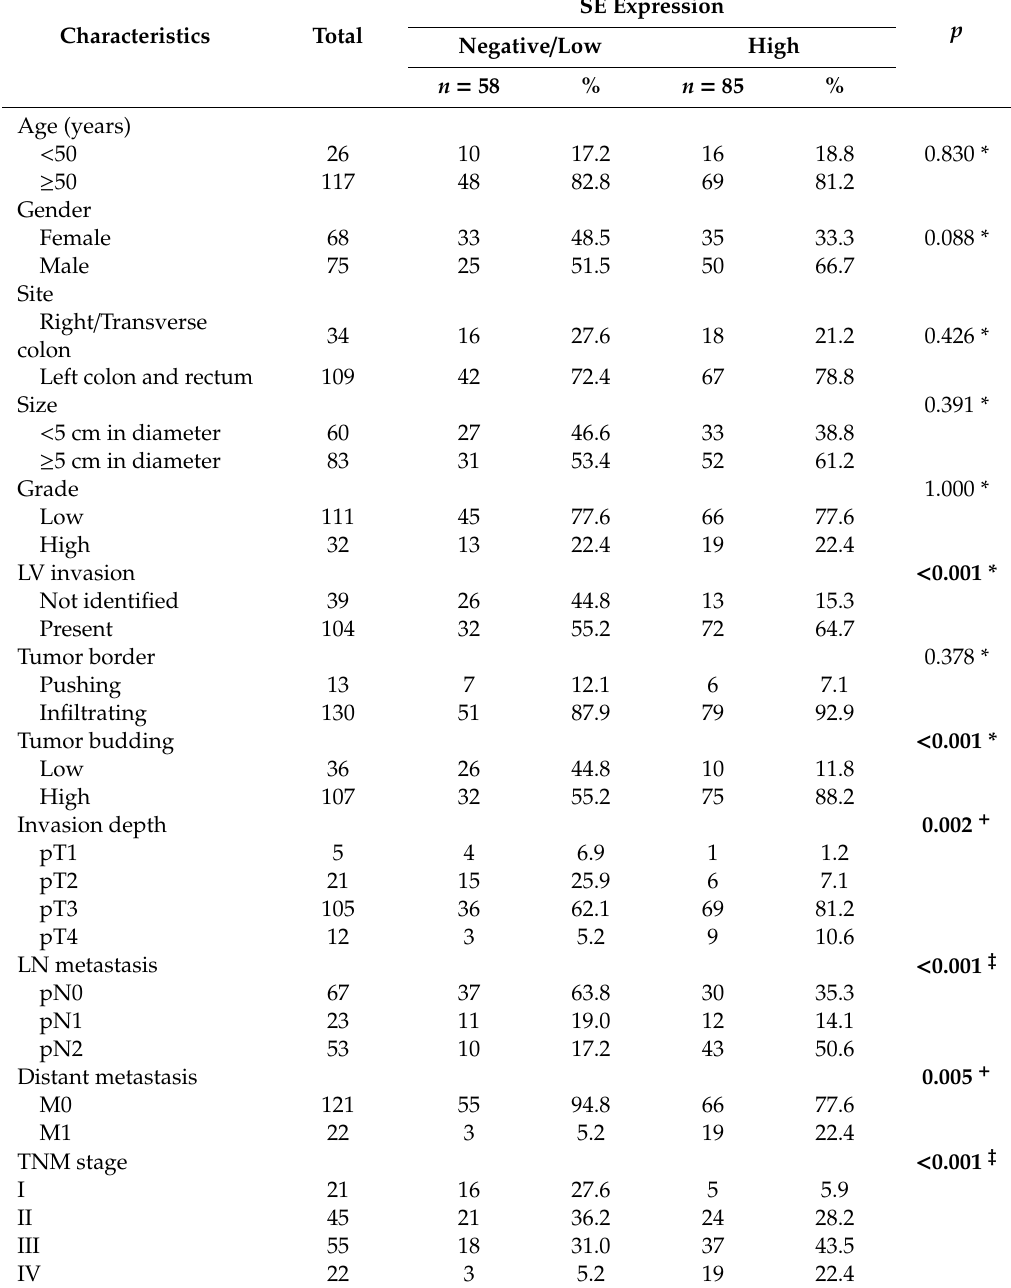
Table 1. Clinicopathologic variables and the expression status of SE at the invasive front in CRC.